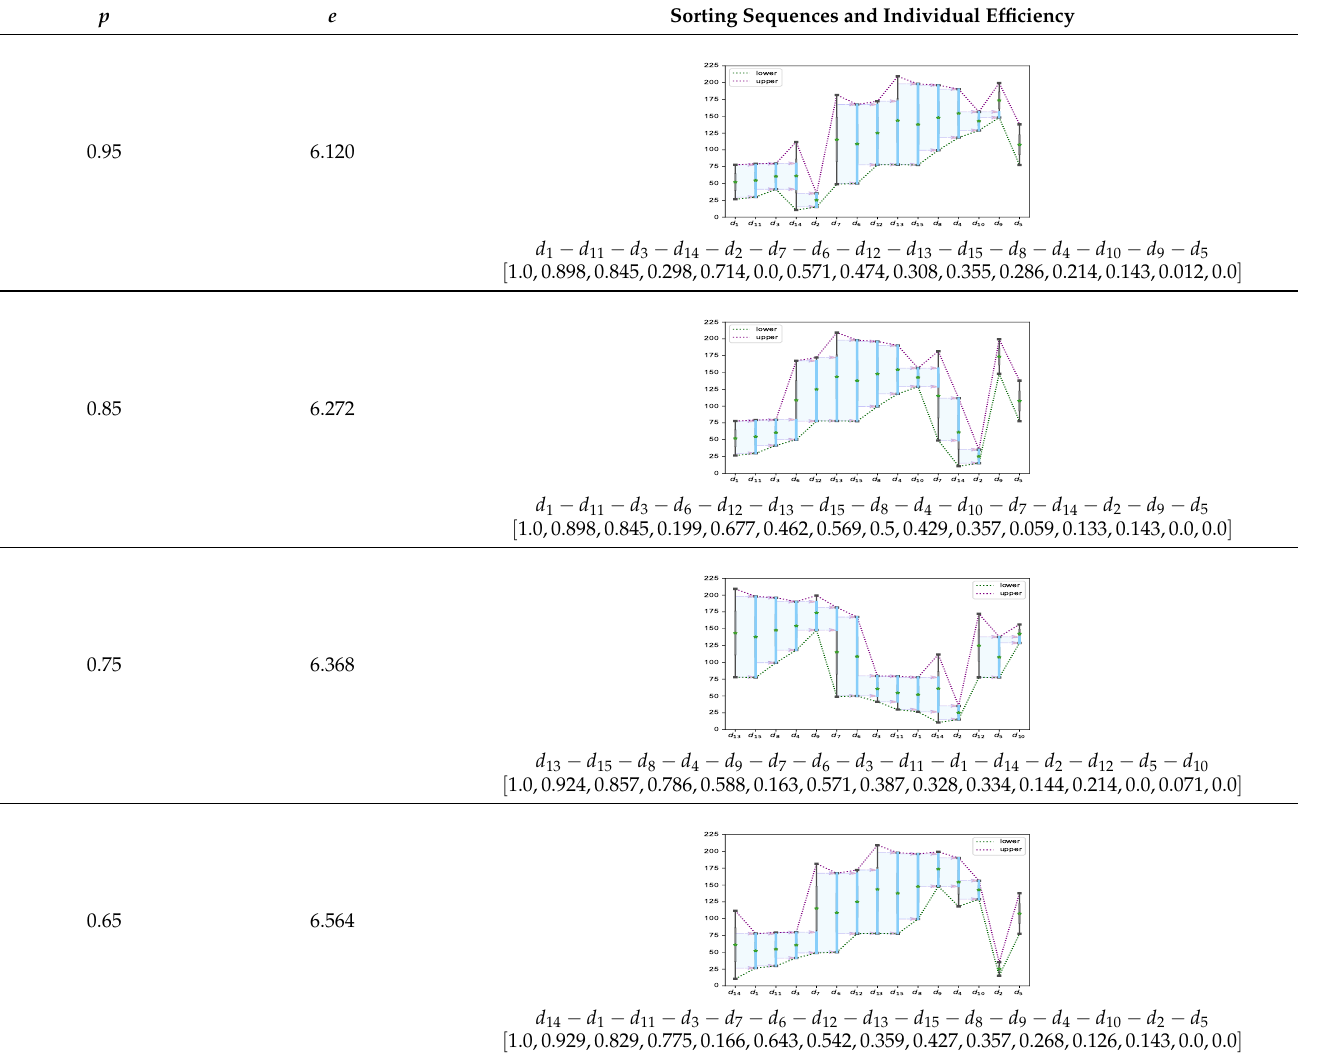
Table A3. Solutions of sorted negotiation Model (19) for different p ( o (cid:48) = 107, B 0 = 2300). p e Sorting Sequences and Individual Efficiency